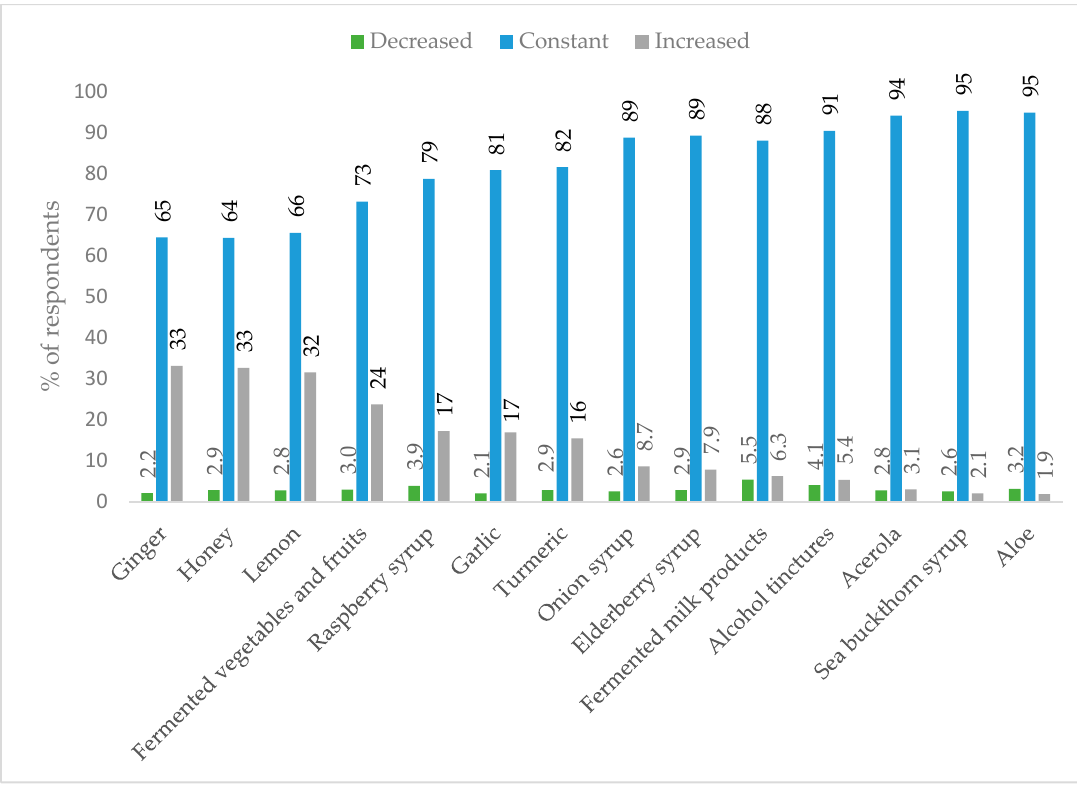
Figure 5. Changes in consumption of herbs and foods—results of the PLifeCOVID-19 Online Study 2 ( n = 978) conducted during the second wave of the pandemic.